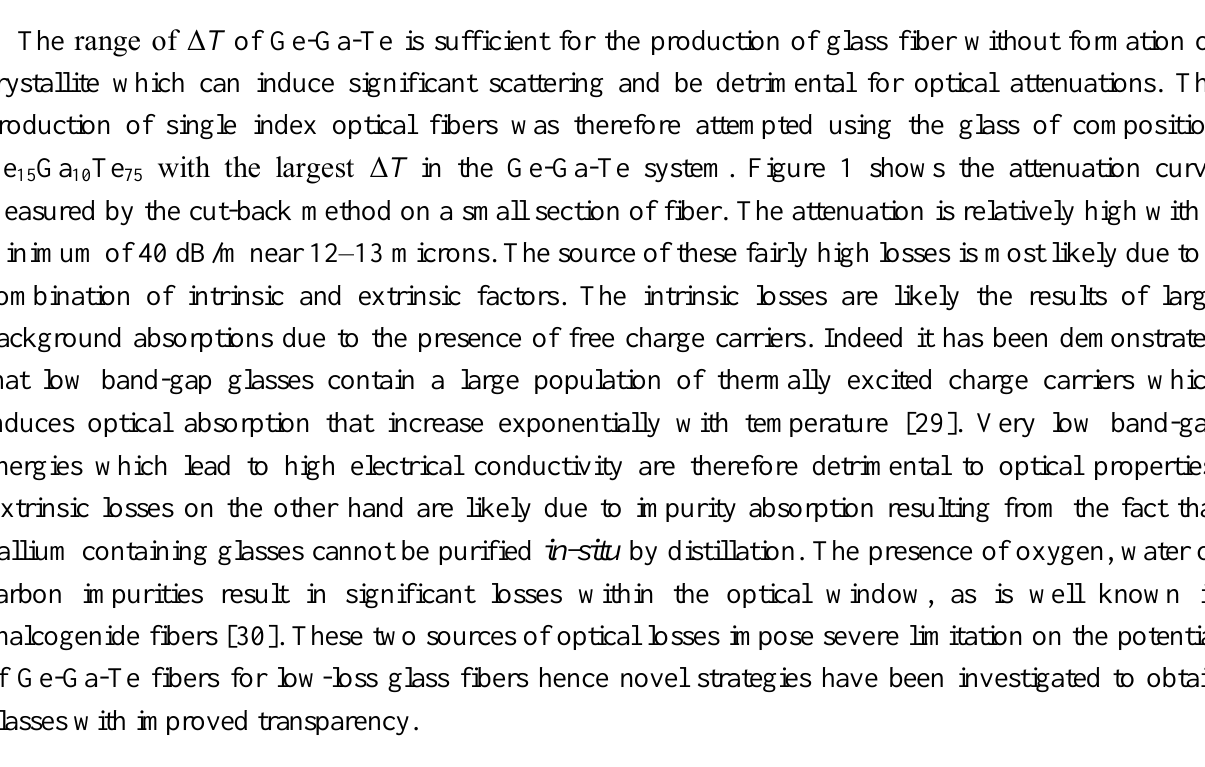
Ga Te glass fiber showing minimum loss around 15 10 75